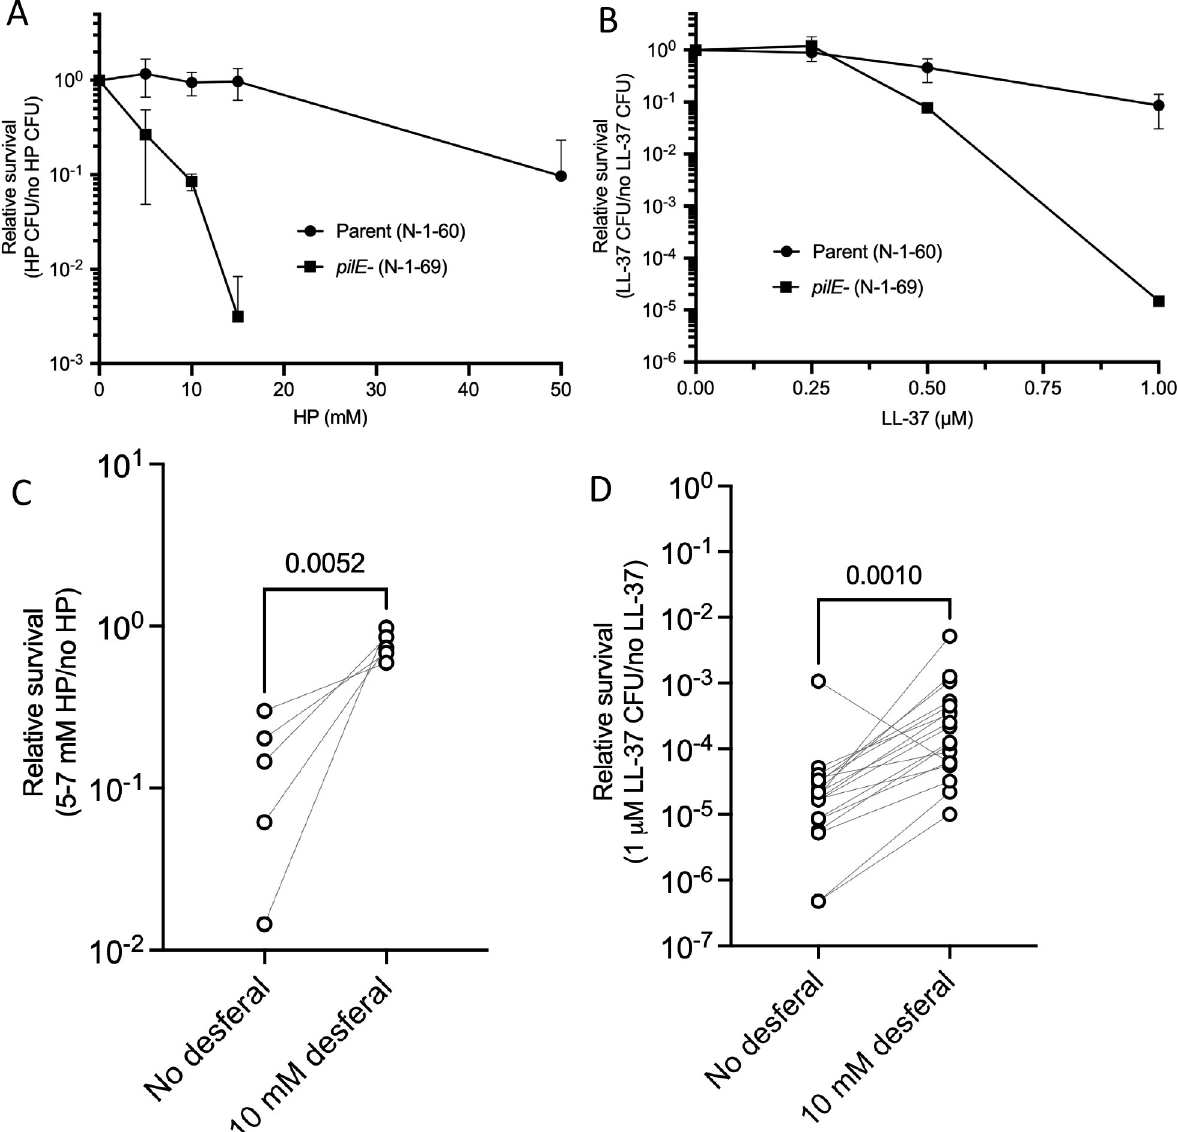
Fig 1. Iron chelation rescues the pilE mutant from HP- and LL-37-mediated killing. Relative survival of the parental strain (N-1-60) and the isogenic pilE mutant (N-1-69) after (A) hydrogen peroxide (HP) treatment or (B) LL-37 exposure. C. Relative survival of the FA1090 pilE mutant after pre-treatment with desferal before HP exposure. D. LL-37 sensitivities of the pilE mutant after desferal treatment. The data are presented with lines to indicate the matched pairs and analyzed by a paired t test in panel C and a Wilcoxon matched pairs signed-rank test in panel D with GraphPad